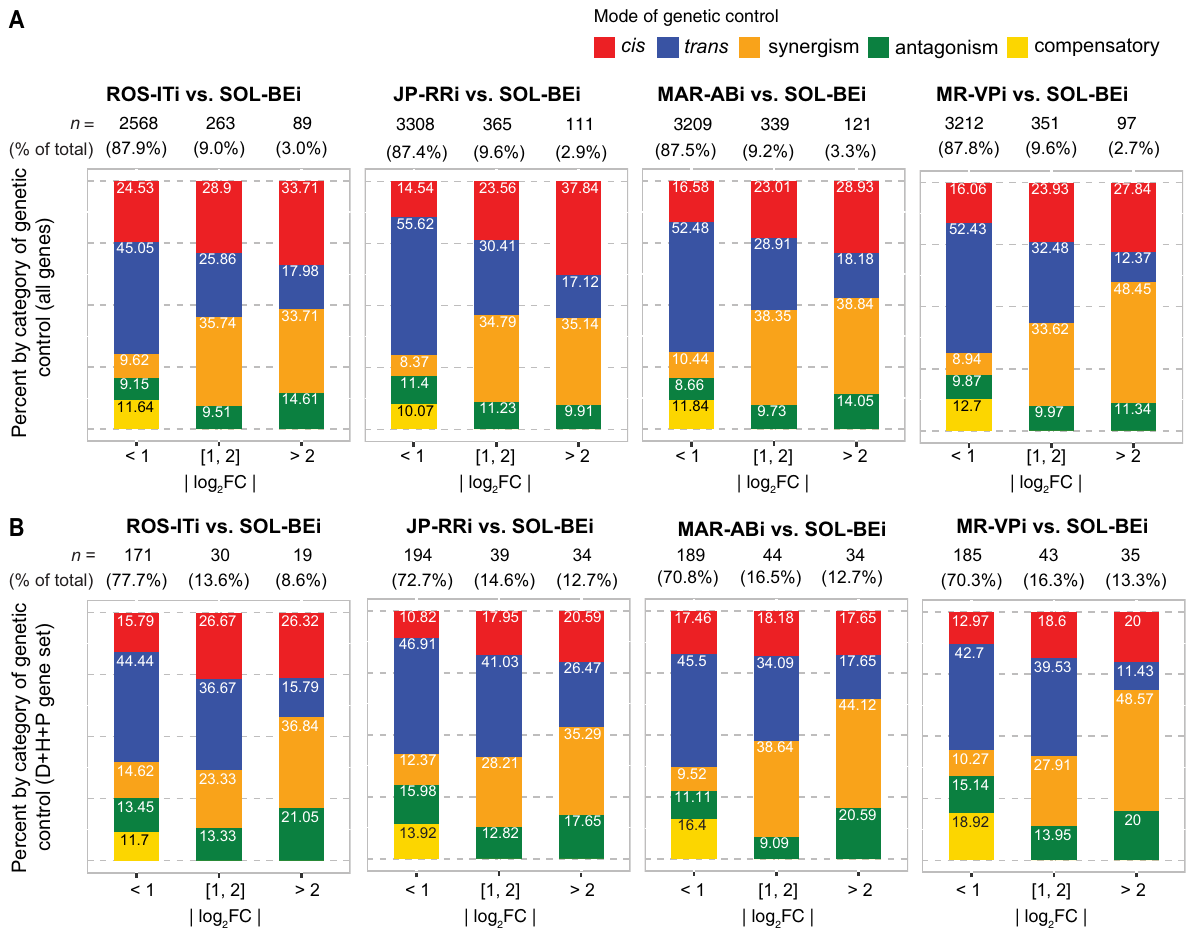
Fig 4. Composition of genetic control categories stratified by magnitude of parental expression fold change differences. (A) For all genes for which cis , trans , synergism, antagonism or compensatory modes of expression control (legend, top right) could be assigned in pairwise strain comparisons, stacked barplots show respective percentages stratified by increasing absolute value of log 2 fold change (|log 2 FC|) bins for parental expression differences (denoted beneath each subpanel; the four genotypic comparisons, as well as respective sample sizes, n , are indicated above each subpanel). (B) Same as for panel (A) except for the subset of genes in the detoxification/host/peptidase (D+H+P) gene set. The data upon which this figure is based are provided in S4 Table.